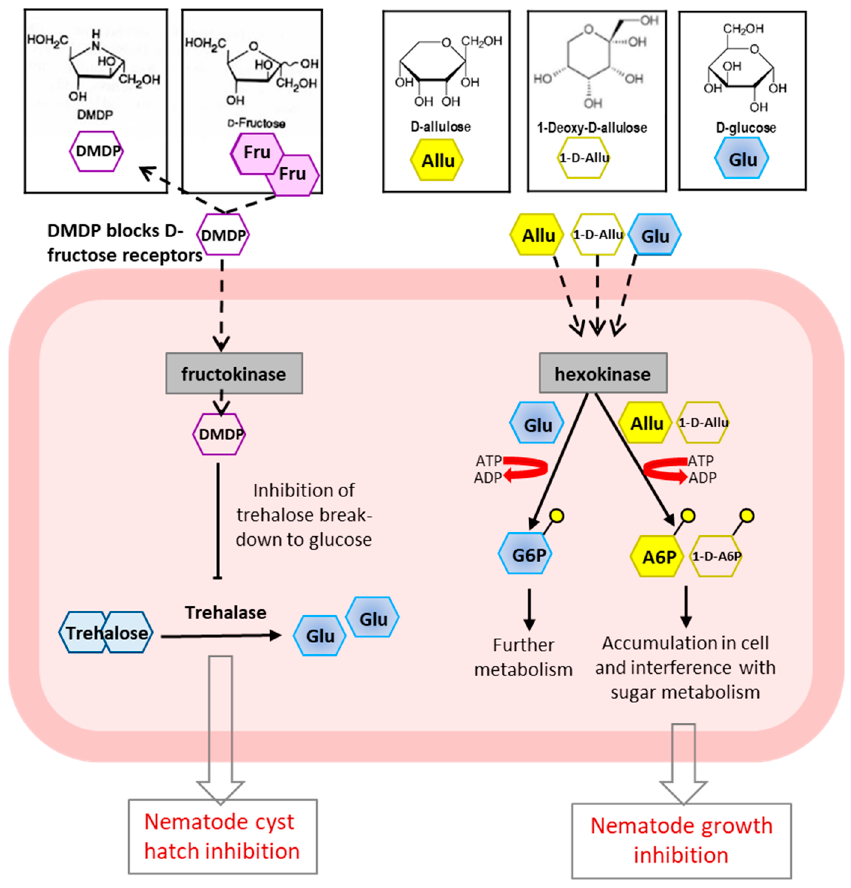
Figure 5. Possible modes of action of fructose analogue-sugar-like 2,5-dideoxy-2,5-imino-D-mannitol (DMDP) and D-allulose/1-Deoxy-D-allulose on nematodes. DMDP (left side), due to its high structural similarity with fructose temporarily blocks the fructose receptors like fruktokinases and in such way disturbs the fructose sensing and signaling pathways. DMDP can be taken up inside the cells where it interferes with the trehalose breakdown and inhibits cyst hatch of nematodes (e.g., potato cyst nematode). On the right side of the figure is the possible C. elegans growth inhibitory action of D-allulose and 1-Deoxy-D-allulose. D-Glc taken up by cells is phosphorylated by hexokinase and D-Glc-6-phosphate is formed through glycolysis. D-Allulose and its deoxy derivate are also phosphorylated by hexokinase; however, the cell is not able to entirely metabolize the newly formed D-allulose/1-Deoxy-D-allulose-6-phosphate. Instead, they accumulate in the cell, inhibiting glycolytic enzymes, thus interfering with sugar metabolism [2].